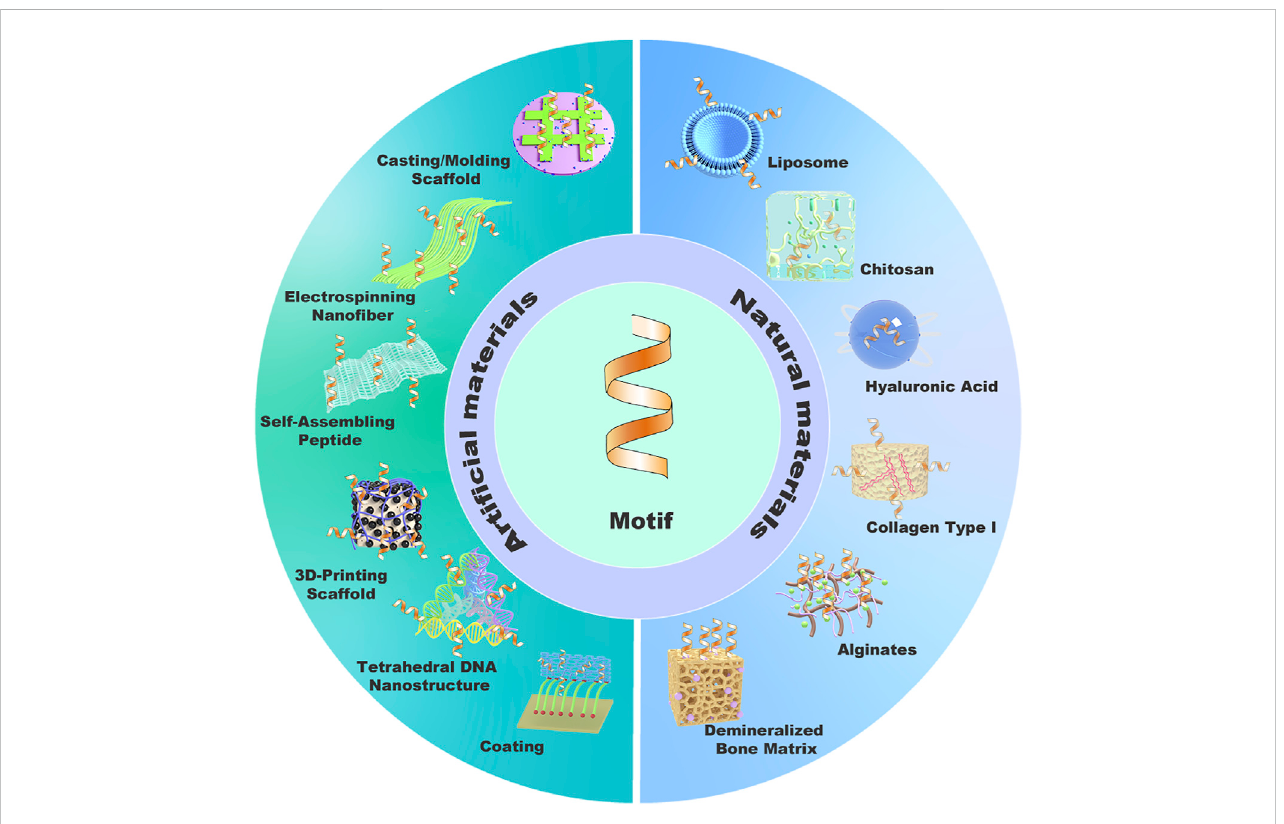
FIGURE 8 Carrier classi fi cations based on material